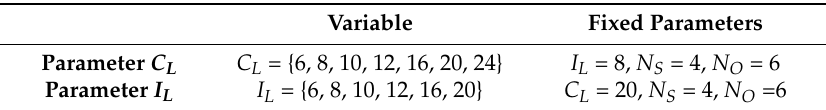
Table 1. Details of the parameter settings.